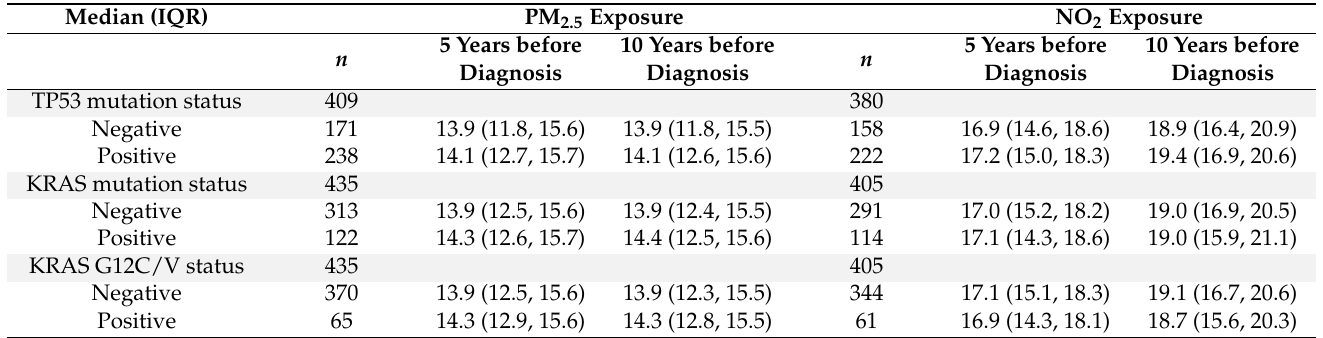
Table 2. Distribution of PM 2.5 and NO 2 exposure according to mutation status.